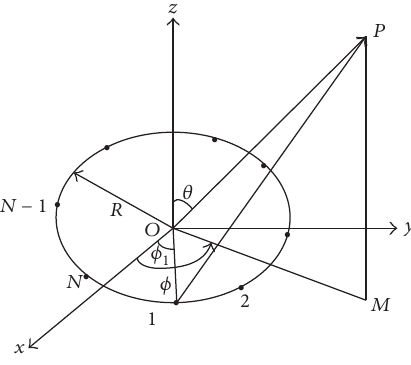
Figure 5: Block diagram of IF digital receiver.